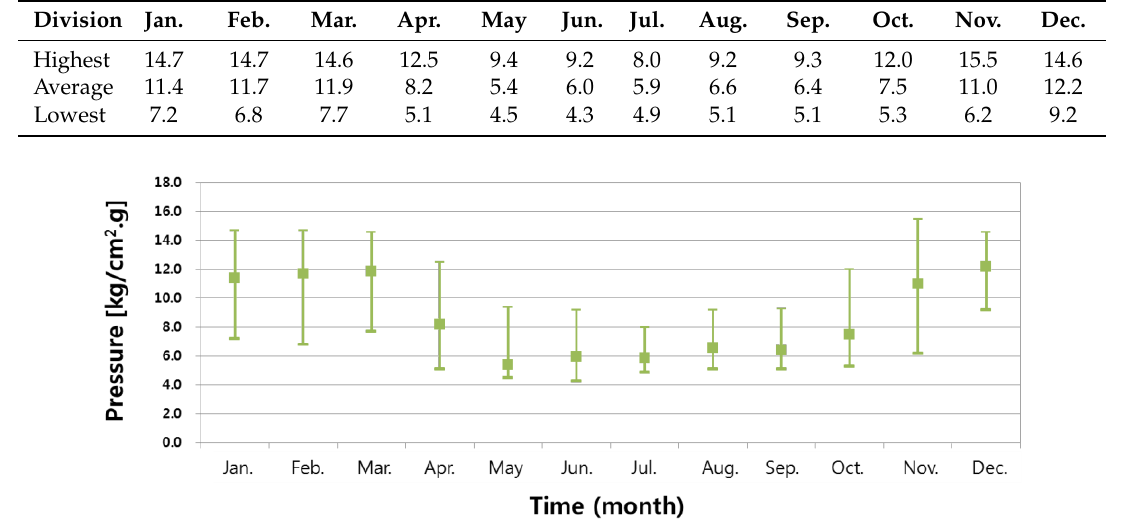
Figure 4. Pressure distributions of DH supply water for a year.